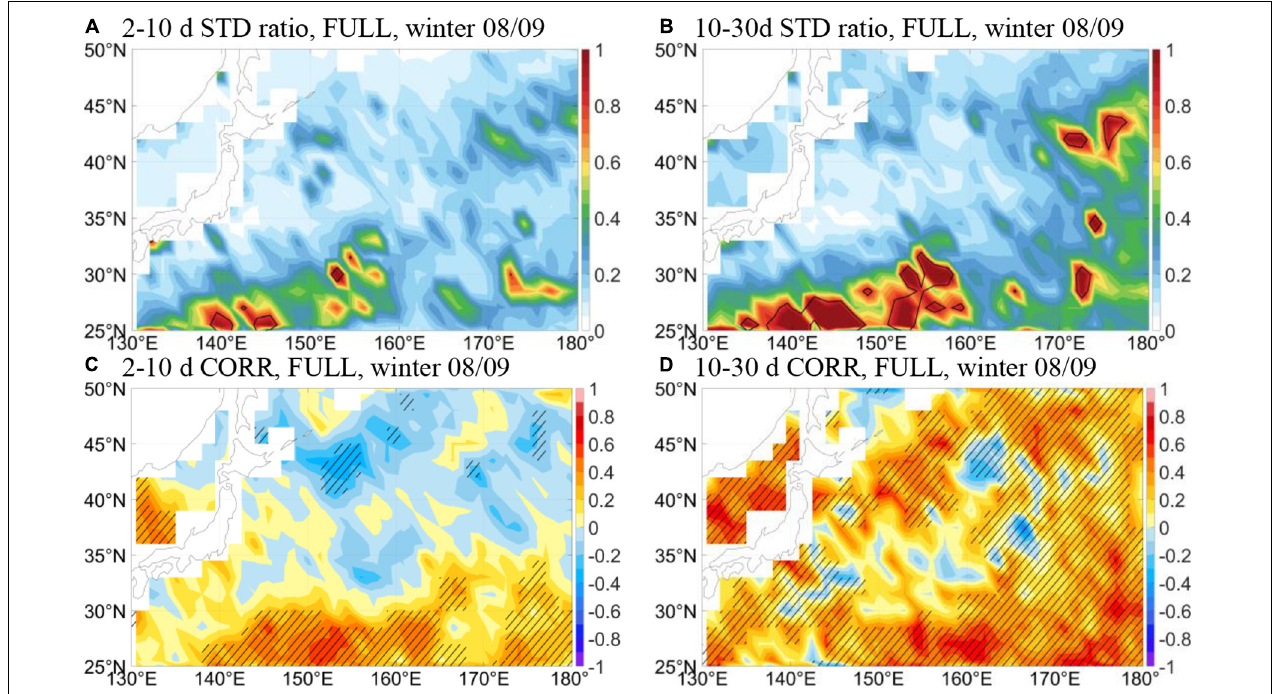
FIGURE 5 | (Upper row) Ratio of standard deviation of SST between the GOTM-FULL experiment and observations in winter 2008/09 on (A) 2–10 days (B) 10–30 days timescales. The black contour indicates the critical ratio at the 95% significance level. (lower row) Correlation between SST of the GOTM-FULL experiment and observations in winter 2008/09 on (C) 2–10 days (D) 10–30 days timescales. Hatched areas indicate statistical significance at the 95%